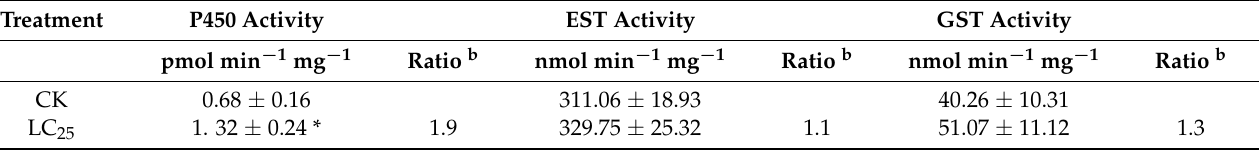
Table 3. Activities of metabolic enzyme in populations with CK and LC 25 treatment of B. tabaci a.